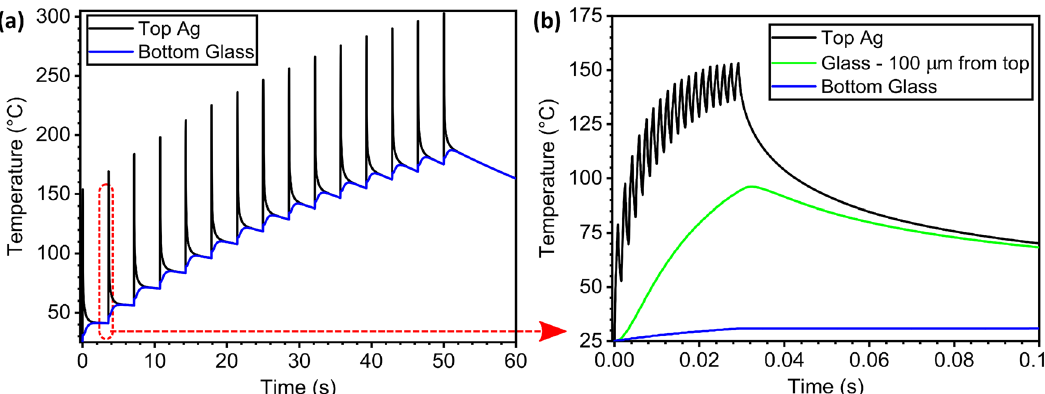
Figure 1. SimPulse simulation of the pulse-train used to process AgNW TCE’s in glass in the Pulseforge ( a ) 15 consecutive pulses. The red oval points to a detailed version of the first pulse in ( b ) Simulation of the effects of a single pulse. For comparison, the green line depicts the simulated temperature profile at 100 µ m under the top surface of the glass substrate and the blue line shows the simulated temperature at the bottom